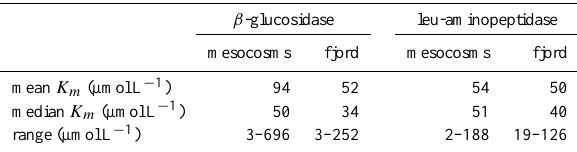
Table 2. Half-saturation constant K m for β -glucosidase and leucine-aminopeptidase activity in mesocosms and Kongsfjorden samples. β